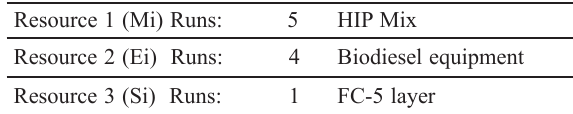
Table 12. Resource results coded in